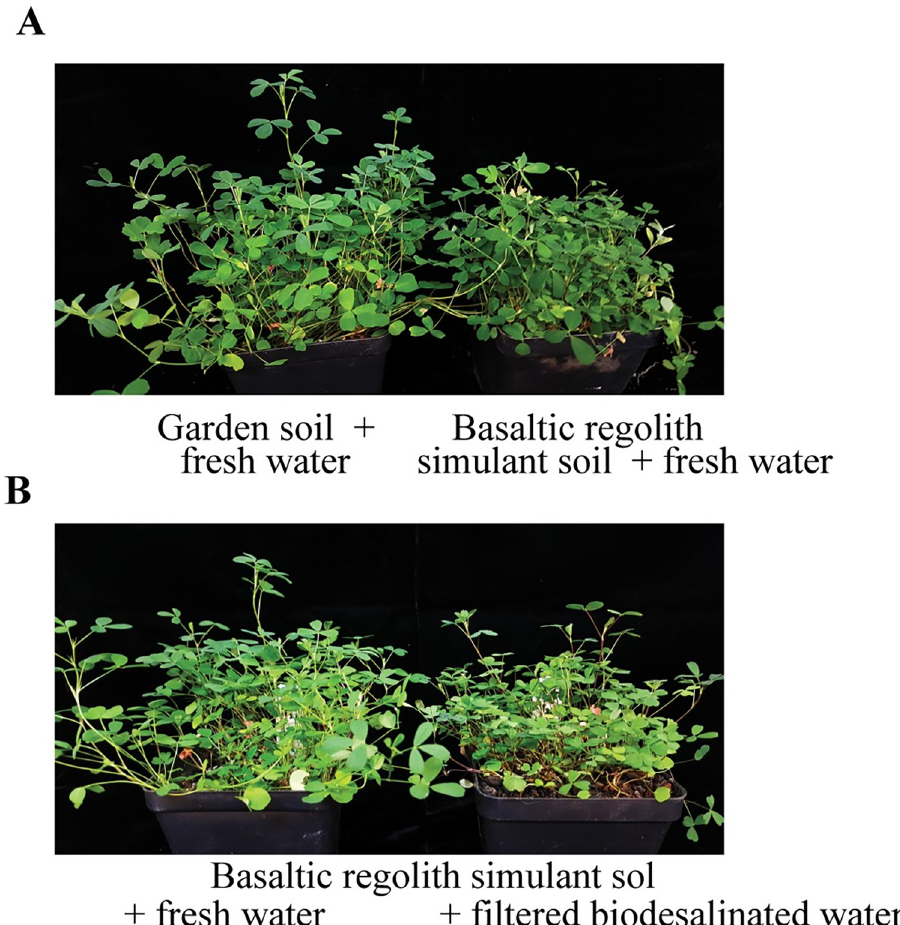
Fig 3. Growth of alfalfa in bare basaltic regolith simulant soil or garden soil watered with (A) fresh water or (B) fresh water or filtered biodesalinated water.